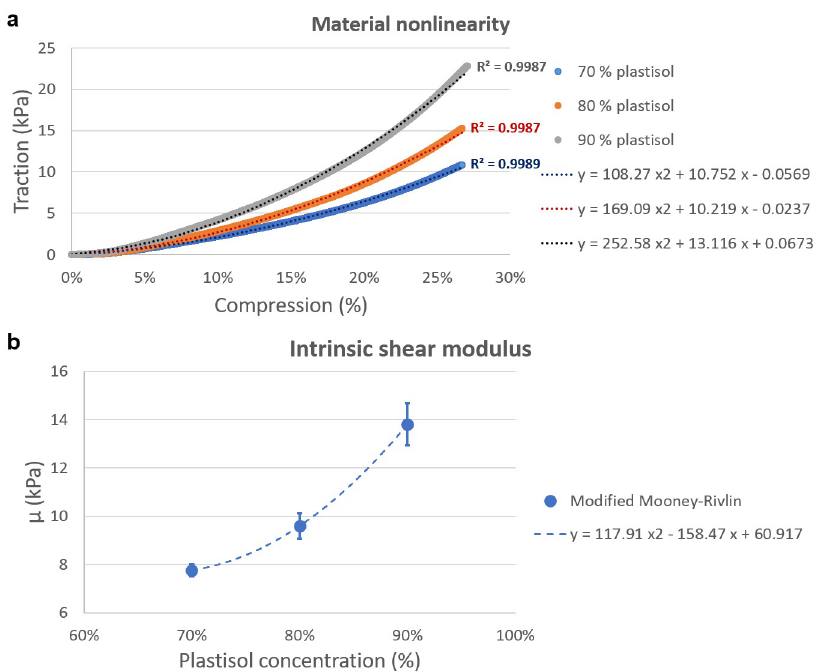
Fig 8. Material stress-strain nonlinearity. (a) The stress-strain response of samples made with different plastisol concentrations was fitted with a second-order polynomial function. The increasing value of the parameter scaling the quadratic term associates a higher plastisol content to an increased material nonlinearity. (b) The intrinsic shear modulus of the material was also found to increase with the amount of plastisol in the mixture, following a quadratic